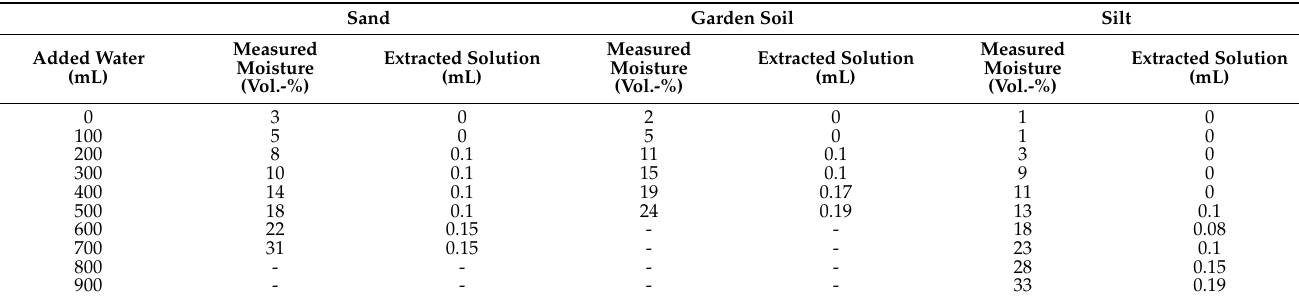
Table 1. Experimental series of water extraction for different soil moisture levels in three types of soil. The moisture level was increased by adding water in steps. The volume of extracted solution for a 30 min pump period was measured. As the experiment was stopped at different amounts of added water, we do not have values for all fields. Sand Garden Soil Silt Added Water